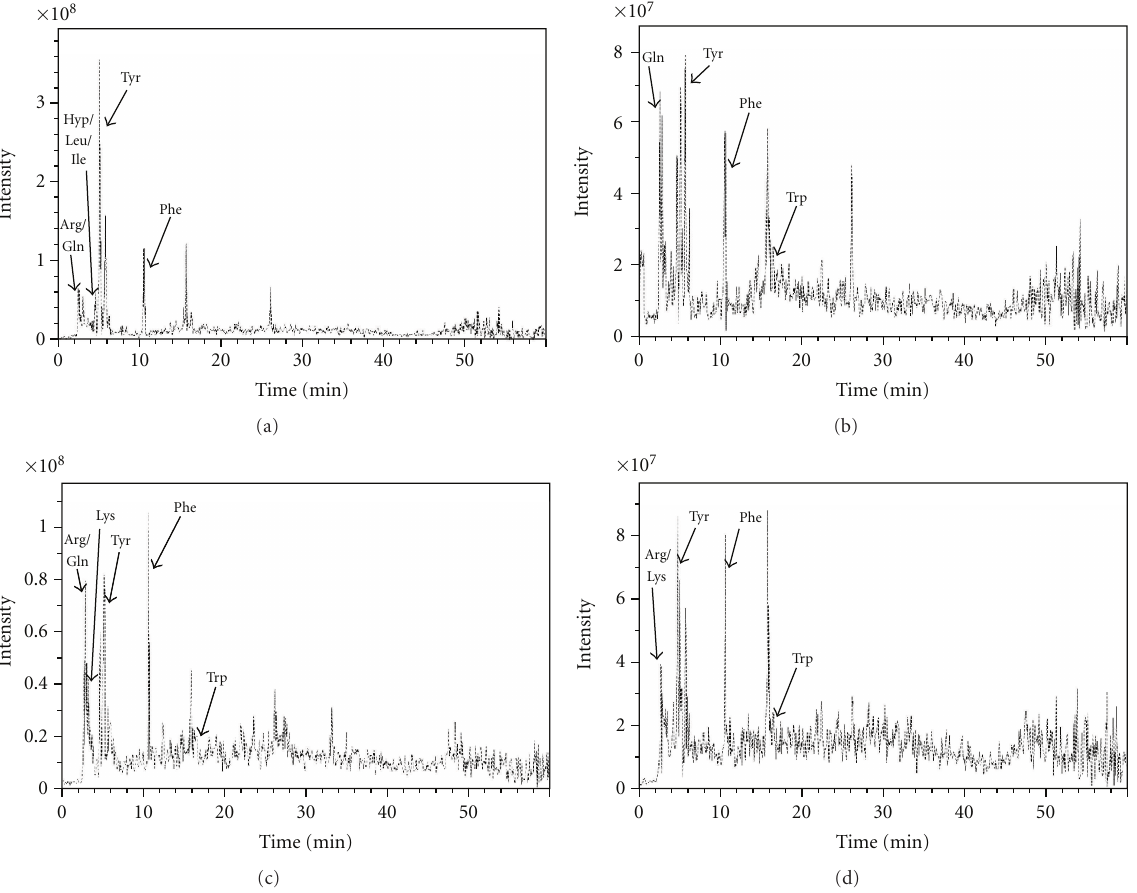
Figure 1: Separation of nontreated horn samples by HPLC/MS: (a) 1.7 PGV identification free amino acids: Arg/Gln (arginine/glutamine); Hyp/Leu/Ile (hydroxyproline/leucine/isoleucine); Tyr (tyrosine); Phe (phenylalanine), (b) 1.7DGV glutamine; tyrosine; phenylalanine; Trp (tryptofan), (c) 3DGV arginine/glutamine; Lys (lysine); tyrosine; phenylalanine; tryptofan, (d) 3DGN arginine/lysine; tyrosine; phenylalanine; tryptofan.